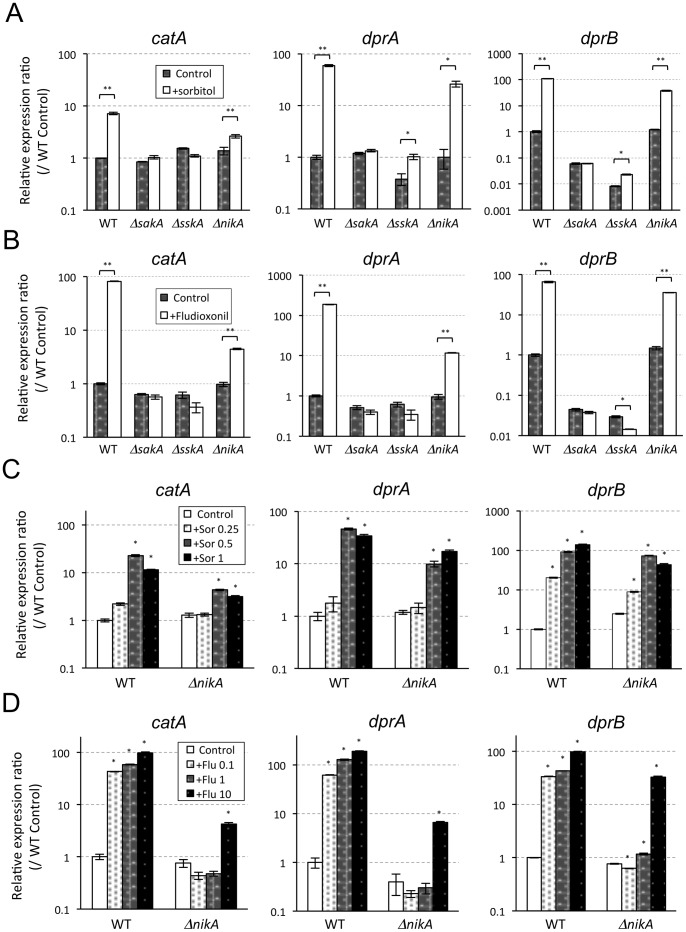
Transcriptional responses of catA, dprA, and dprB to osmotick shock and fungicide.(A and B) WT, ΔsakA, ΔsskA, and ΔnikA were grown in liquid YGMM for 18 h at 37°C. Then, sorbitol (A) or fludioxonil (B) was added (1 M or 10 µg/mL final concentrations, respectively). As a control, an equivalent volume of water or DMSO was added to the cultures (indicated as Control). After 15 min, the mycelium was harvested, and the RNA was extracted. cDNAs was synthesized and used for real-time RT-PCR analysis. Relative expression ratios were calculated relative to the WT control. Error bars represent the standard deviations based on three replicates. P-values were calculated by the Student’s t-test: *P<0.005; **P<0.001, compared to the Control in any strain. (C and D) WT and ΔnikA were grown in liquid YGMM for 18 h at 37°C. Then, different concentrations of sorbitol (0.25, 0.5, and 1 M final concentrations) (C) or fludioxonil (0.1, 1, and 10 µg/mL final concentrations) (D) were added. After 15 min, the mycelium was harvested, and the RNA was extracted. cDNAs was synthesized and used for real-time RT-PCR analysis. Relative expression ratios were calculated relative to WT. Error bars represent the standard deviations based on three replicates. *statistically significant difference relative to the Control in any strain (P<0.05). P-values were calculated by student’s t-test followed by Bonferroni method.